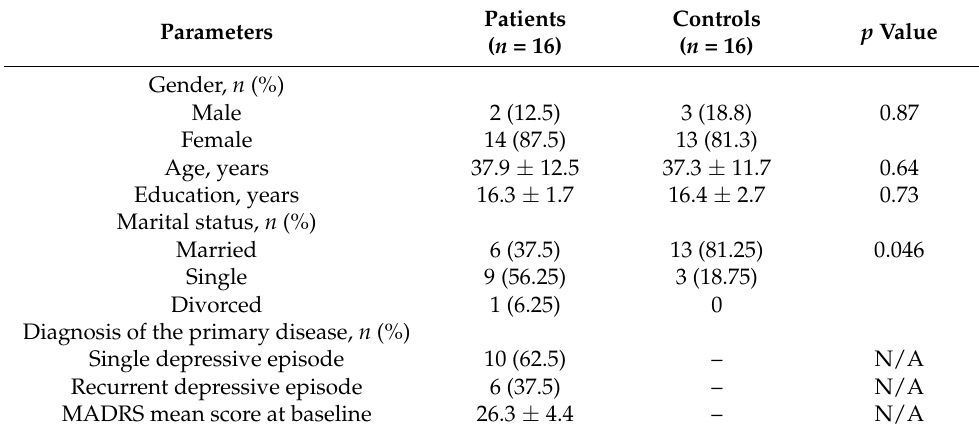
Table 1. General characteristics of study participants (Akhapkin et al., 2021)